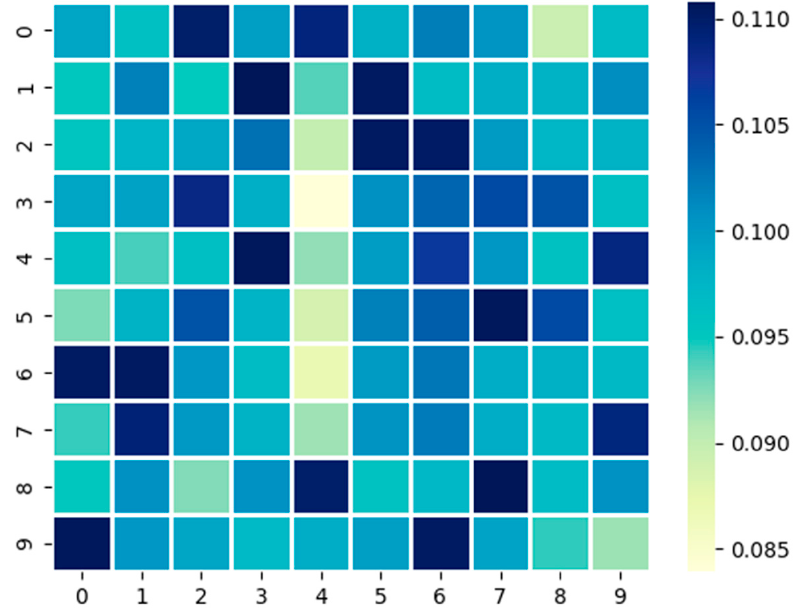
Figure 10. The mean of the entropy values obtained in Figure 8.